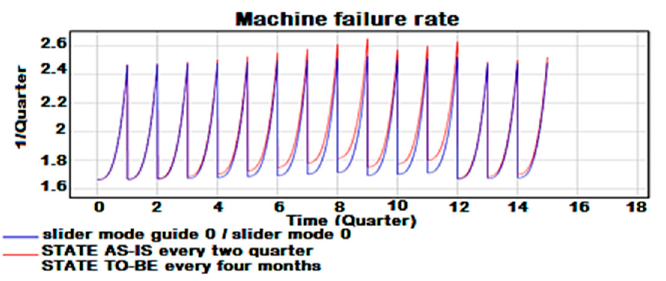
Figure 14. Machine failure rate diagram.